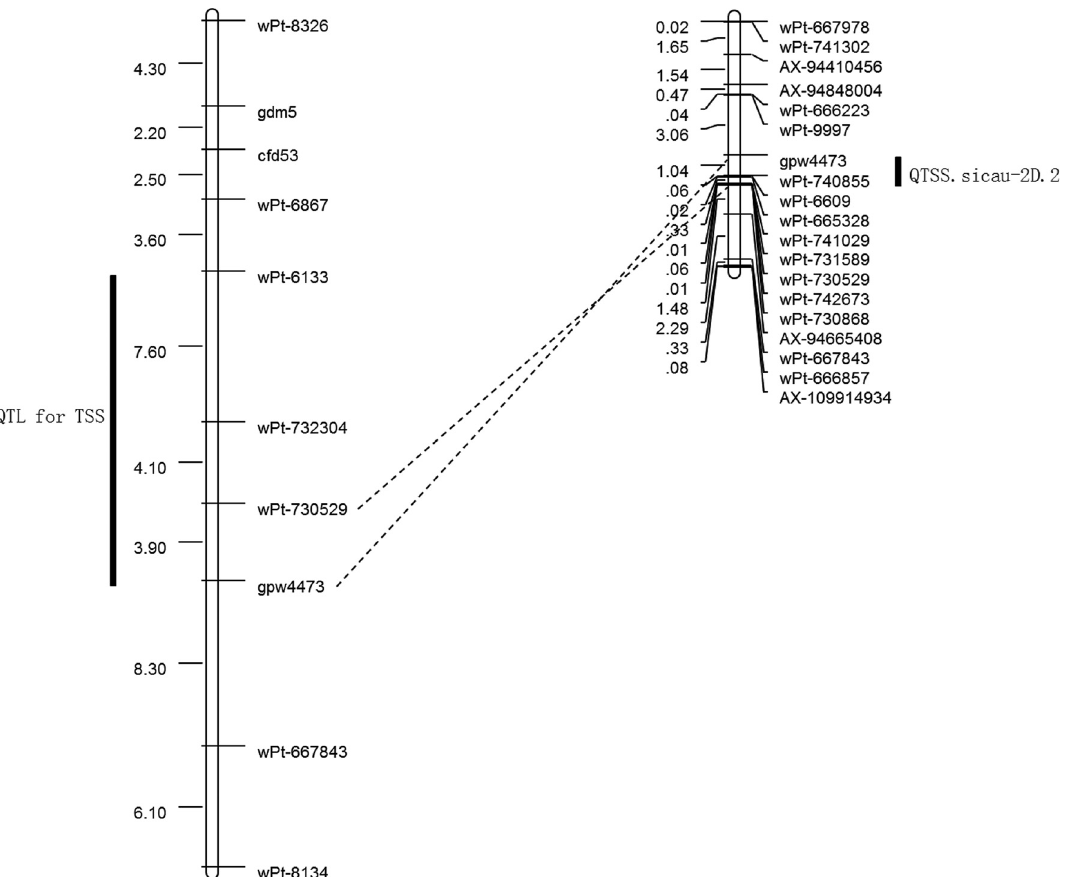
Figure 3 - A comparison of stable putative QTL for TSS between a former study (Yu et al. , 2014) and our result. The left side shows the results of previ- ous studies, and the right side shows the results of our